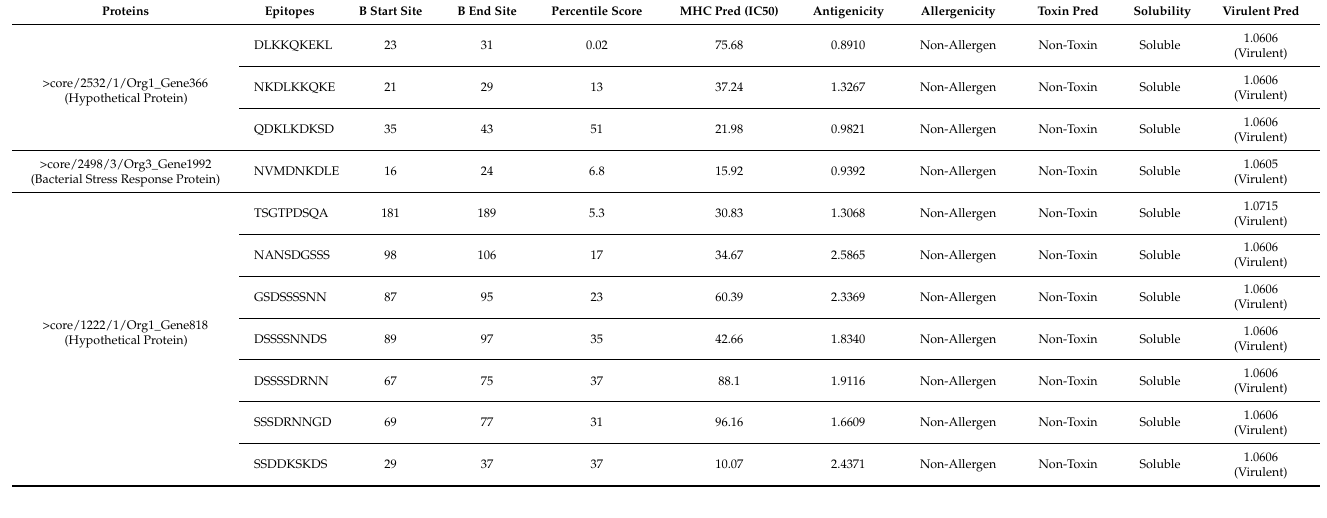
Table 1. Filtered epitopes for shortlisted prioritized proteins.